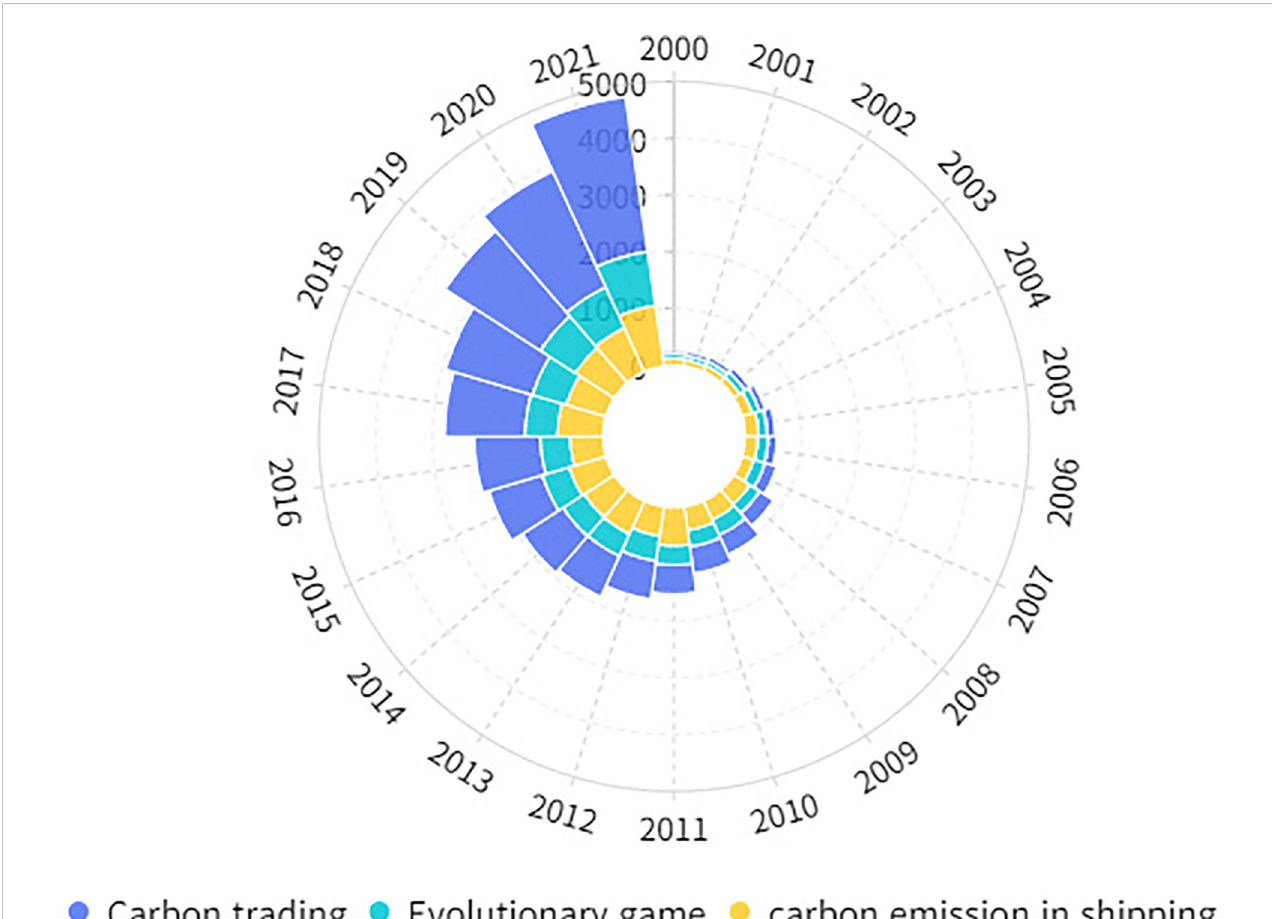
FIGURE 1 Statistics on the number of literatures from